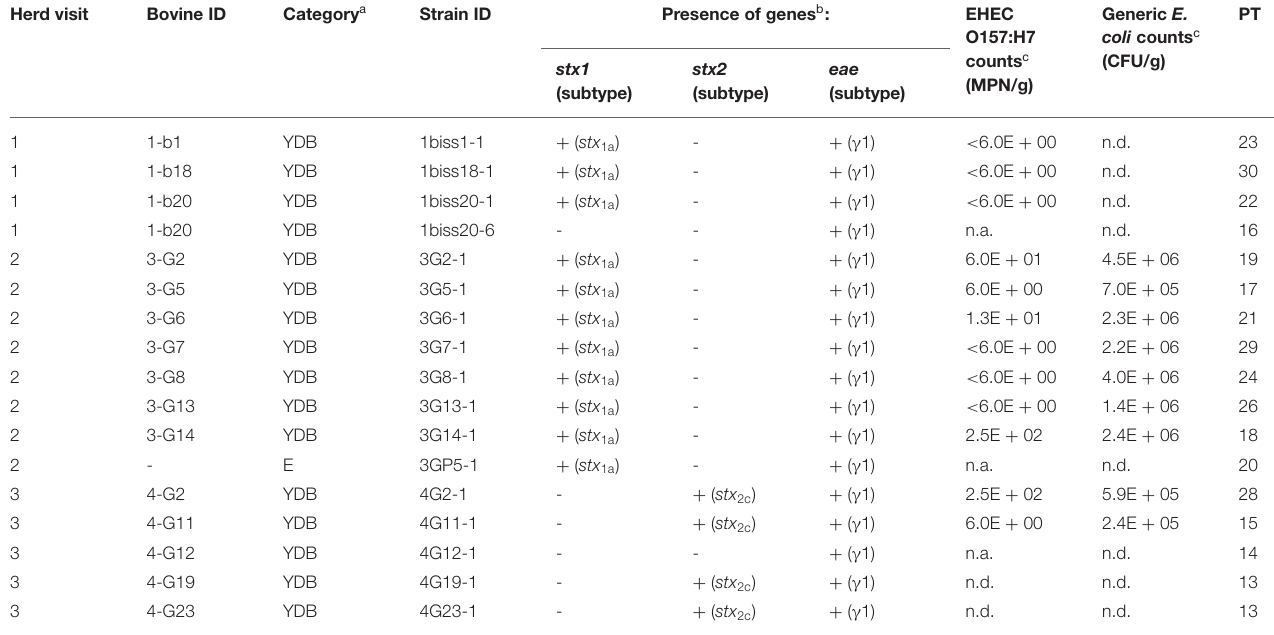
TABLE 2 | Origin, virulence profiles, counts, and PFGE types (PT) of EHEC and EPEC O157:H7 isolated from fecal or environmental samples and counts of generic Escherichia coli in farm G. Herd